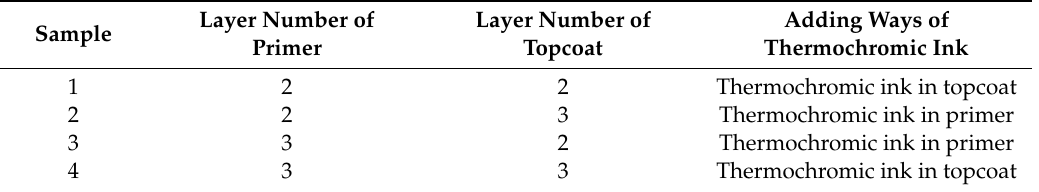
Table 1. Orthogonal experiment design of the coating process.